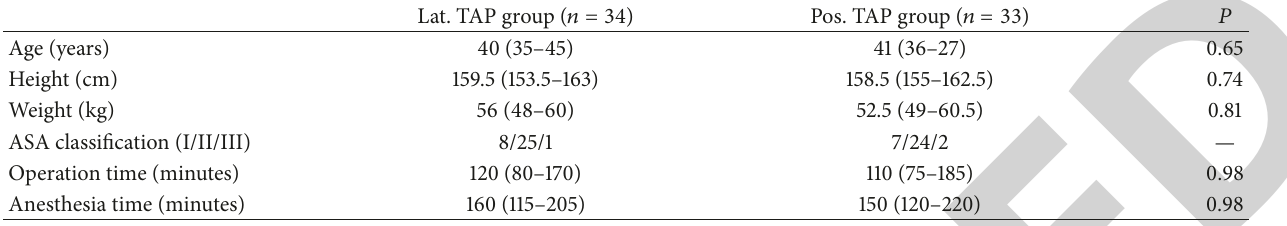
Table 1: Patients demographics data: age, height, weight, operation time, and anesthesia time. Data except ASA classification expressed as median (twenty-fifth to seventy-fifth percentiles). ASA classification expressed the